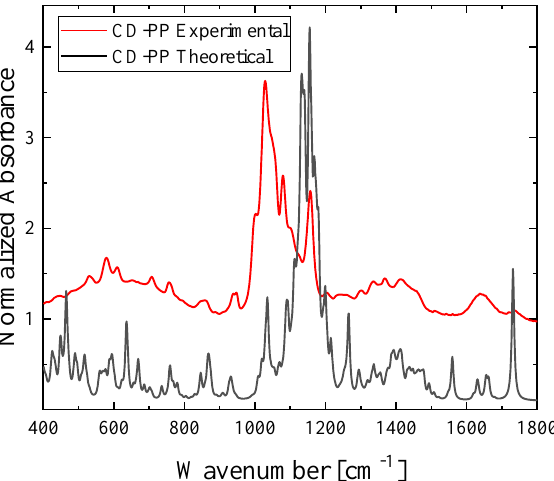
Figure 7. Comparison between experimental and theoretical IR spectra of the CD – PP inclusion complex.